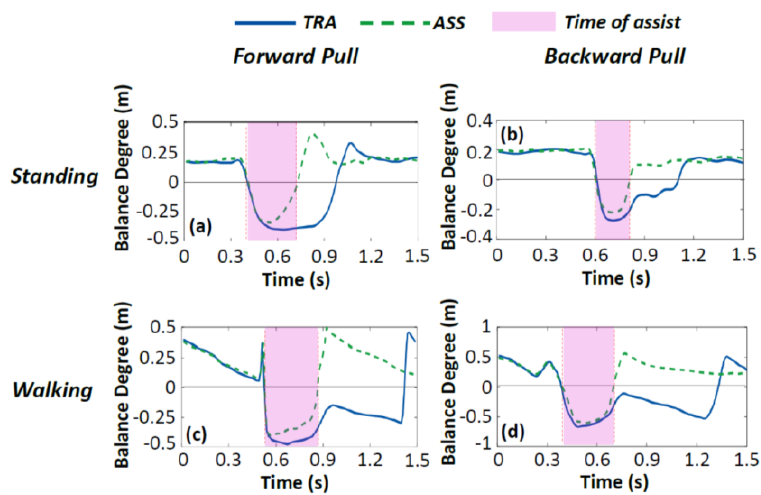
Figure 14. The degree of single step balance: ( a ) Forward pull while standing; ( b ) Backward pull while standing; ( c ) Forward pull while walking; ( d ) Backward pull while